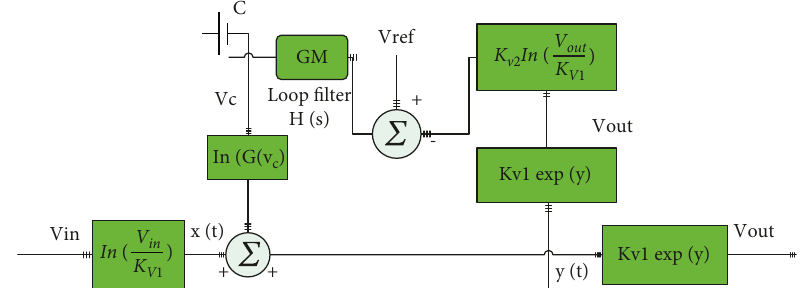
Figure 10: Logarithmic domain model of automatic gain control